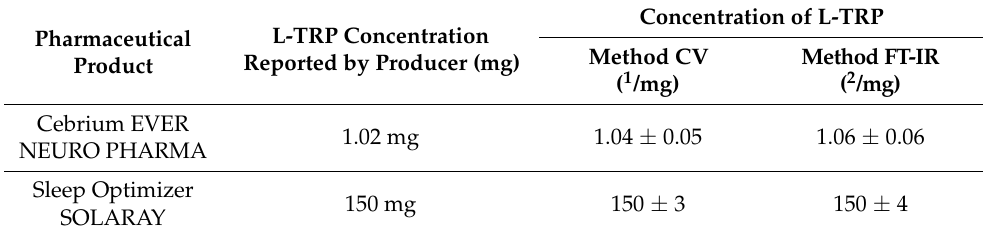
Table 5. Quantitative determination of L-TRP in pharmaceutical